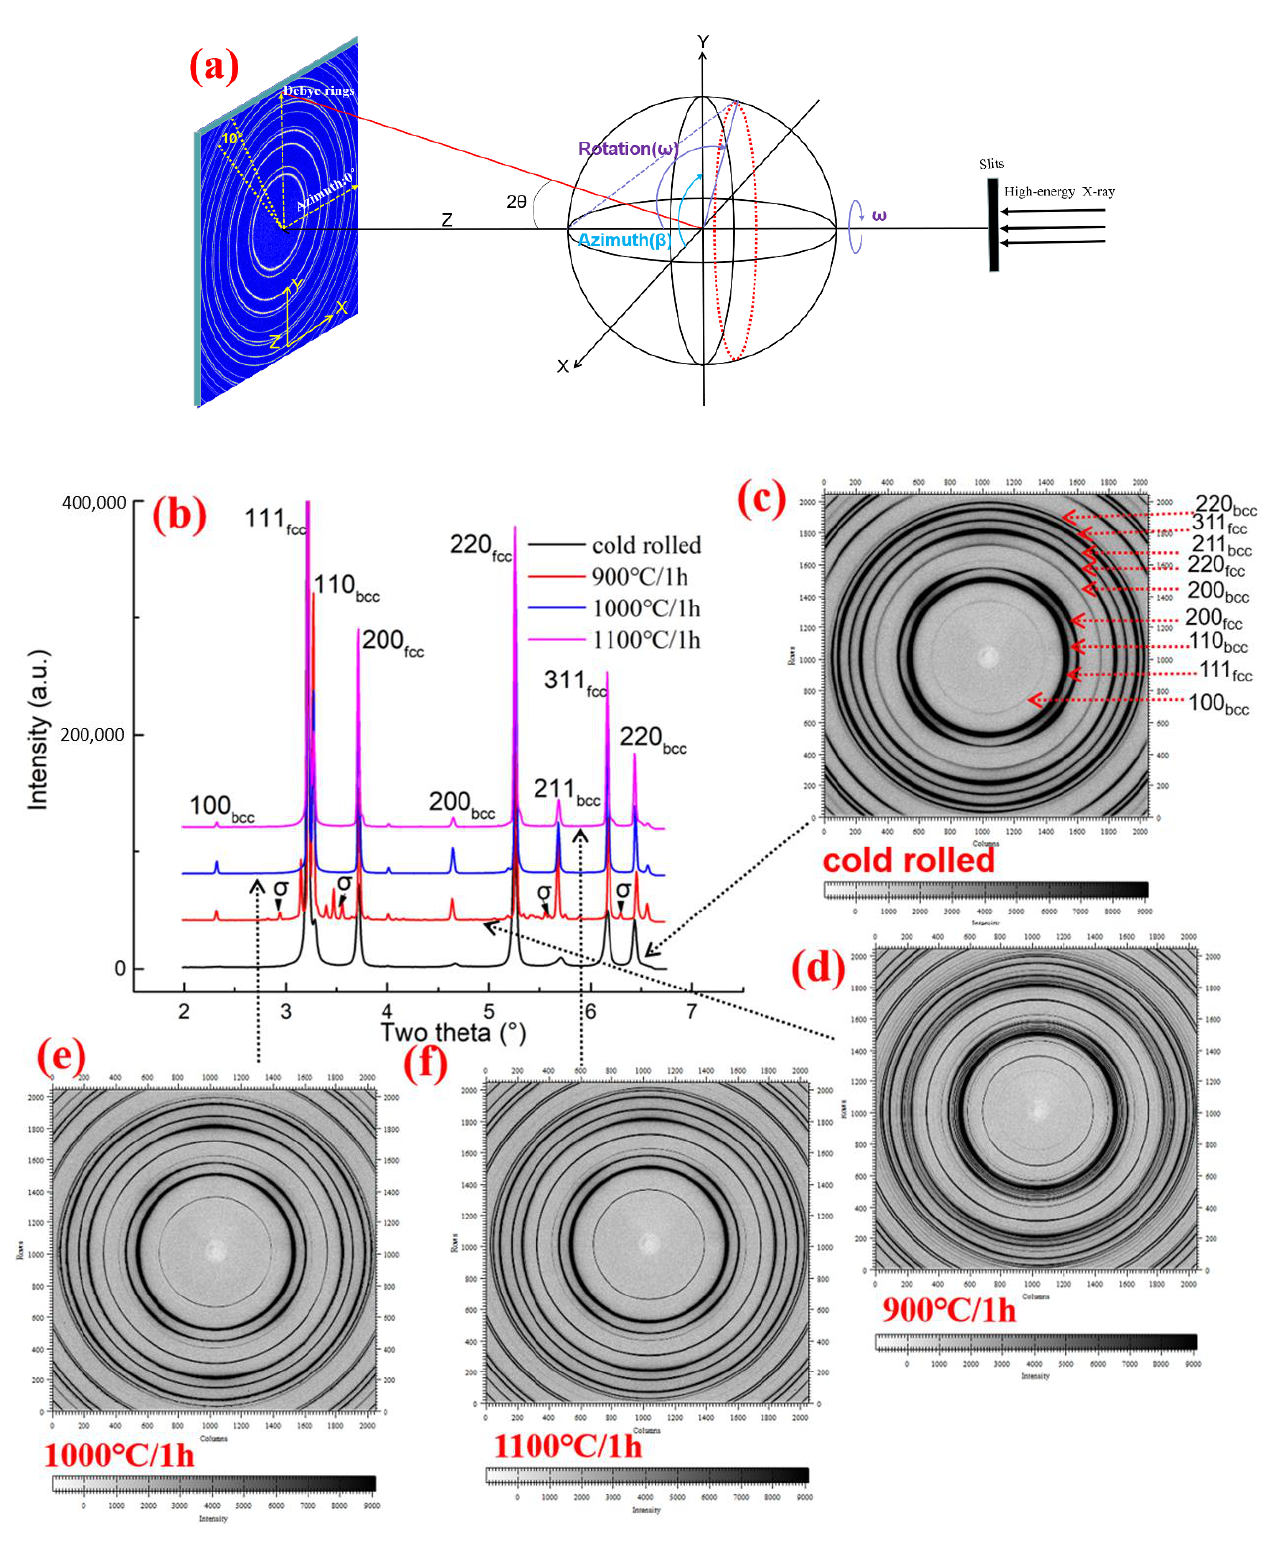
Figure 1. ( a ) Schematic of the in situ HE-XRD texture experiment setup. Note that rotation ( ω ): 0–180 ◦ , and the rotated angle with the z -axis, azimuth ( β ): 0–360 ◦ . ( b ) One-dimensional (1D) HE–XRD patterns; ( c – f ) two-dimensional (2D) Debye ring patterns of the alloy in different annealed states.